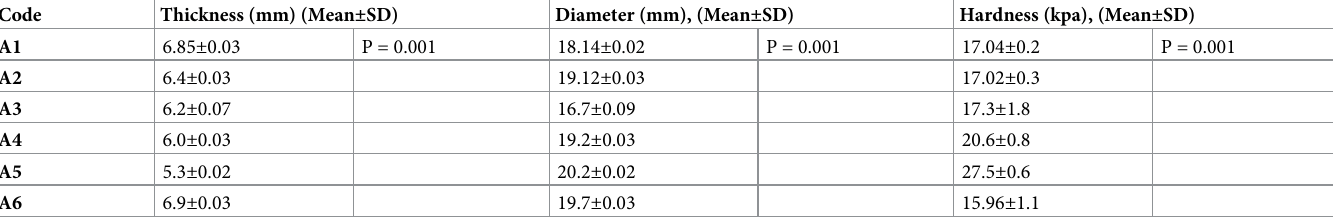
Table 4. Thickness, diameter, and hardness test